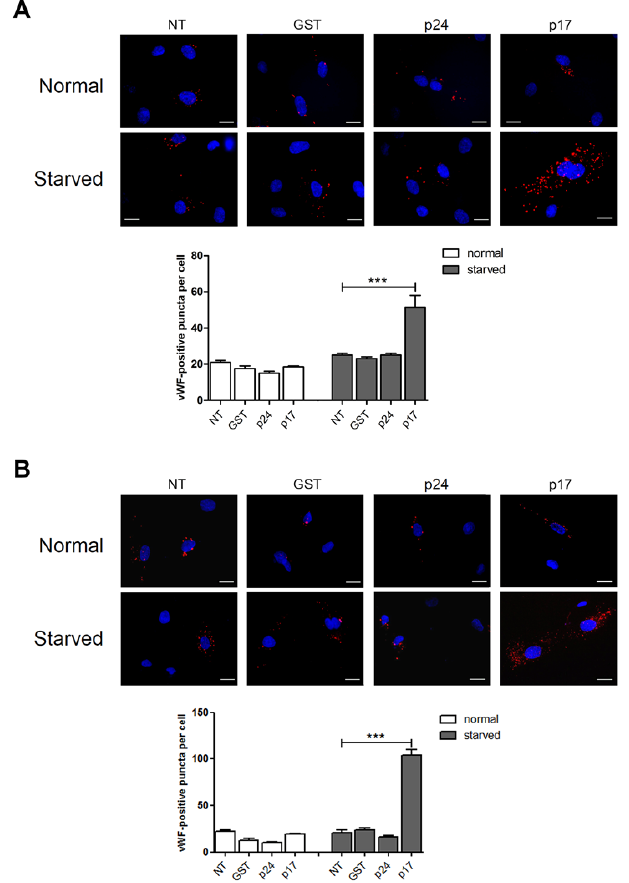
Figure 1. The HIV-1 matrix protein p17 induces von Willebrand factor (vWF) accumulation in Weibel-Palade bodies (WPBs) under serum deprivation. HUVECs ( A ) and HMVEC-Ls ( B ) were nucleofected with a mCherry-vWF-expressing plasmid and 24 h after nucleofection cells were starved or not for 16 h and then stimulated in the presence or absence of 10 ng / mL of GST, p24 or p17 in complete medium. The images display vWF signals in red and cell nuclei in blue. Scale bar, 10 µ m. Red-positive punctate structures were counted in order to quantify the levels of WPBs. NT indicates not treated cells. Values reported for vWF positive structures are the mean ± SD of 3 independent experiments with similar results. Statistical analysis was performed by one-way ANOVA, and the Bonferroni post-test was used to compare data (*** p < 0.001).